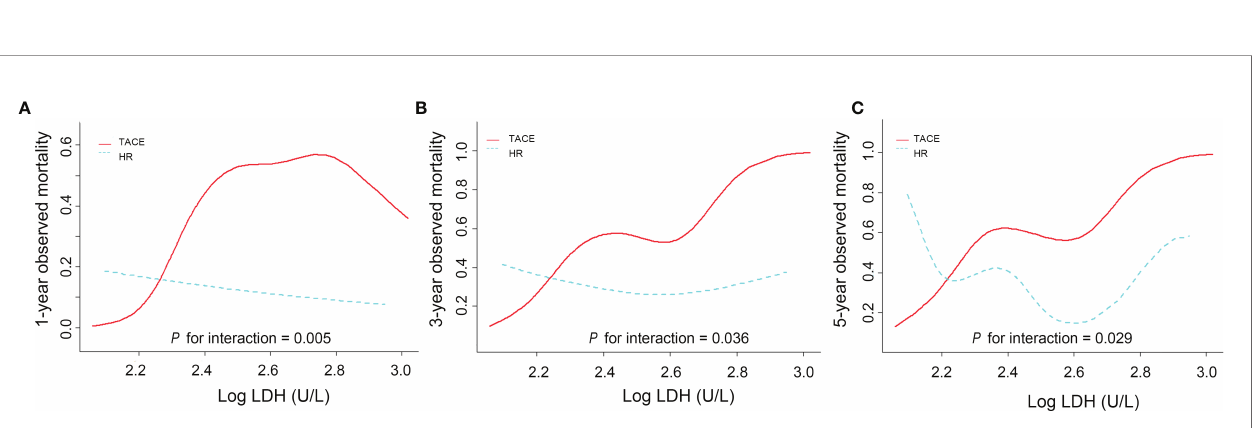
FIGURE 4 | Curve smoothing between LogLDH and observed mortality at 1 (A) , 3 (B) , and 5 (C) years strati fi ed by hepatic resection (HR) and transarterial chemoembolization